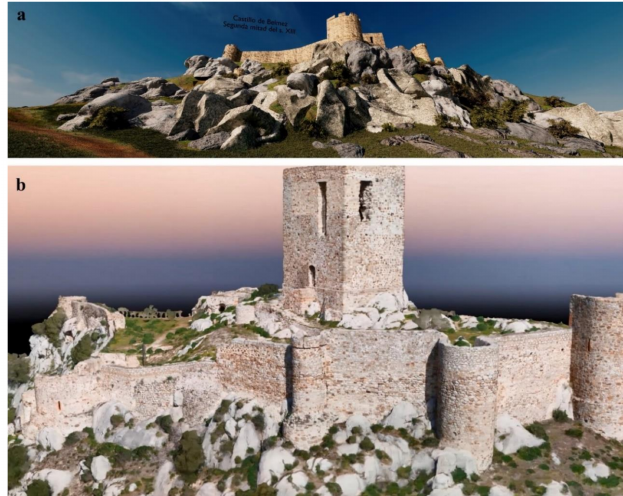
Figure 13. ( a ) Medieval Castle of Belmez shown using VR. ( b ) Photogrammetric acquisition acquired by drone. Images from Lithodomos VR and ZNIR for “Ager Mellariensis” / AEI FEDER HAR